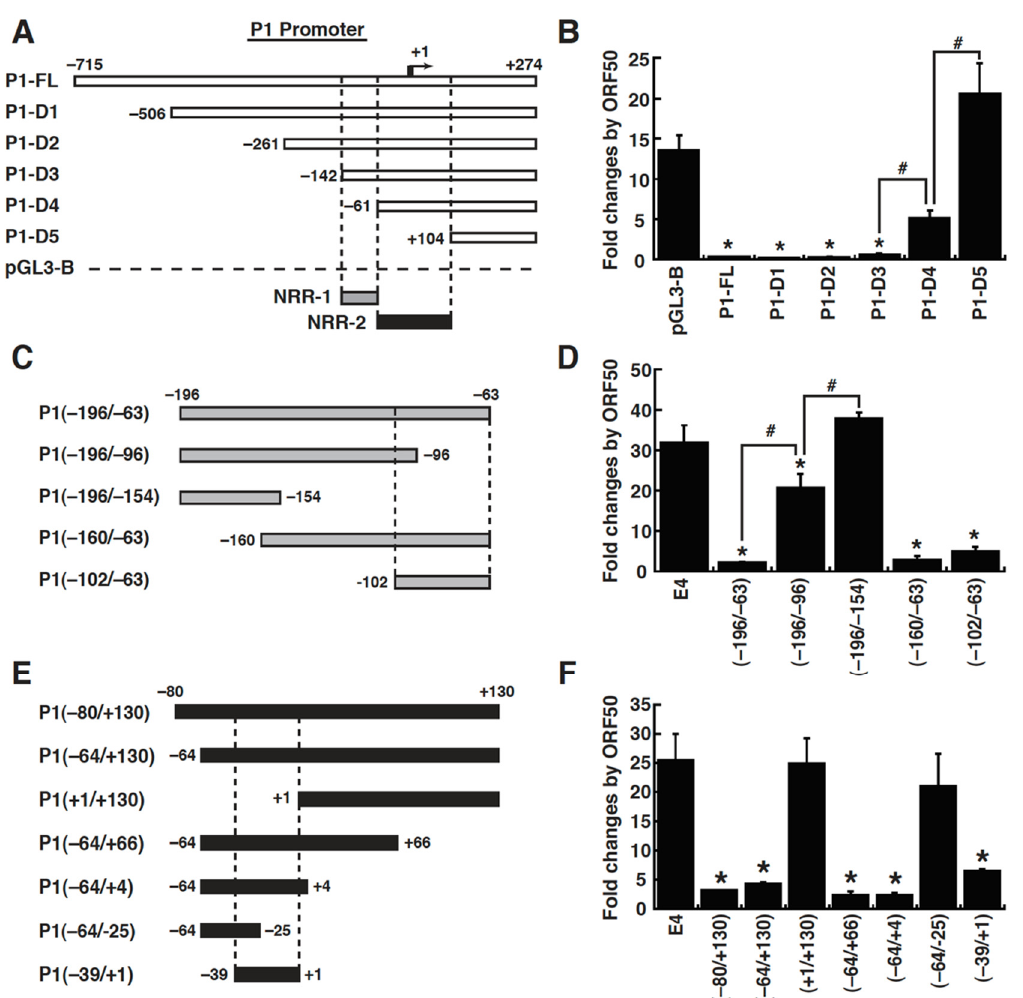
Figure 5. Mapping of the ORF50-dependent negative response element in the P1 promoter of the MDM2 gene. ( A ) Schematic diagram of the promoter–reporter constructs with sequential deletions of the P1(–715/+274) promoter region. Two promoter regions, including NRR-1 and NRR-2, critical for ORF50-mediated repression are shown in the diagram. ( B ) Responsiveness of the reporter constructs with the P1 promoter regions to ORF50 in 293T cells. The indicated reporter constructs were cotransfected with the empty vector or the ORF50-expressing plasmid into 293T cells. After 30 h, cells were lysed, and the luciferase reporter activity was measured. Fold change data of reporter constructs were calculated as the luciferase activity in the presence of ORF50 divided by the luciferase activity in the absence of ORF50. *, p < 0.05, compared to pGL3-Basic; #, p < 0.05, compared to the indicated reporter constructs (n = 3). ( C , D ) Fine mapping of a minimal ORF50-dependent negative response element in the P1(–196/–63) region. The P1(–196/–63) promoter region and its 5 (cid:48) or 3 (cid:48) deletions in the diagram were cloned into pE4-luc. The responsiveness of the indicated reporter constructs to ORF50 was determined in 293T cells. Fold change data of these reporter constructs were calculated as the luciferase activity in the presence of ORF50 divided by the luciferase activity in the absence of ORF50. *, p < 0.05, compared to pGL3-Basic; #, p < 0.05, compared to the indicated reporter constructs (n = 3). ( E , F ) Fine mapping of a minimal ORF50-dependent negative response element in the P1(–80/+130) region. The P1(–80/+130) promoter region and its deletion fragments shown in the diagram were cloned into pE4-luc. The responsiveness of the indicated reporter constructs to ORF50 was analyzed in 293T cells. *, p < 0.05, compared to pE4-luc (n =